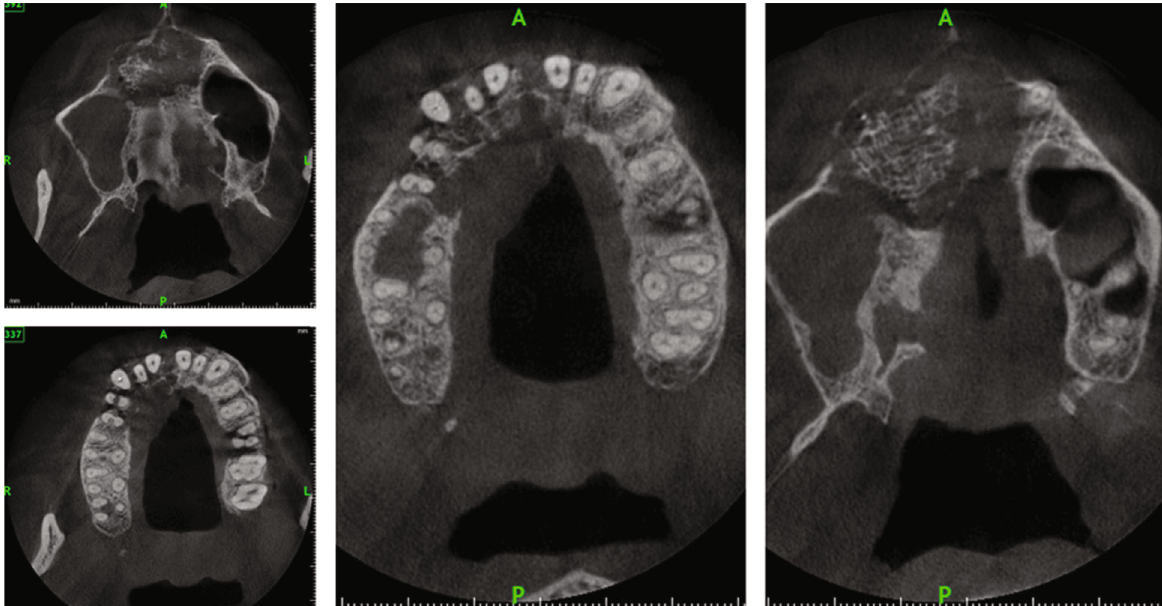
Figure 7: CBCT axial views of case 2 showing gross osteolytic changes with bony sequestrum with haziness on the right maxillary sinus.